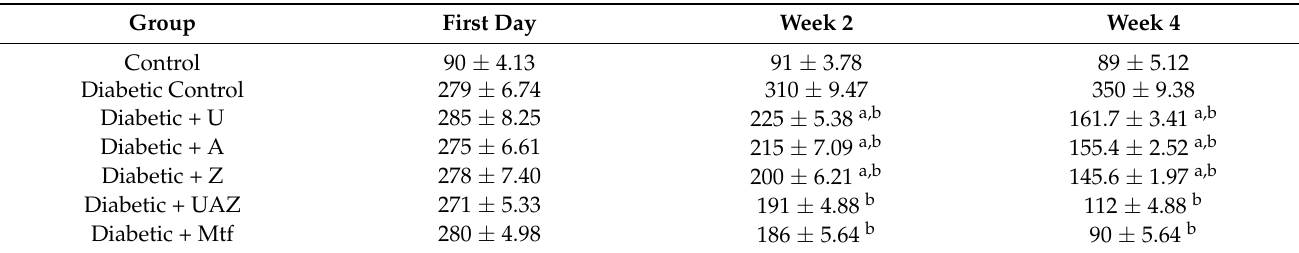
Table 2. Fasting blood sugar in normal and streptozotocin-induced diabetic mice with polyherbal formulation (UAZ), and extracts from U. dioica (U), A. graveolens (A), and Z. officinale (Z) in days 0, 2 weeks, and 4 weeks of treatment.